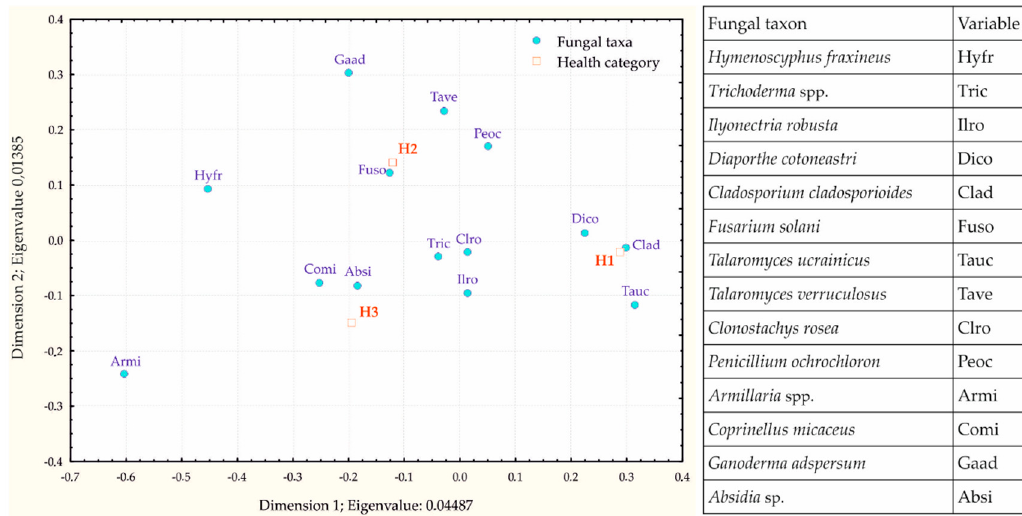
Figure 4. Correspondence analysis map showing association of the 13 most frequent fungal taxa and Hymenoscyphus fraxineus with tree health categories (H1 = crown defoliation ≤ 25%, H2 = crown defoliation 26–60%, H3 = crown defoliation